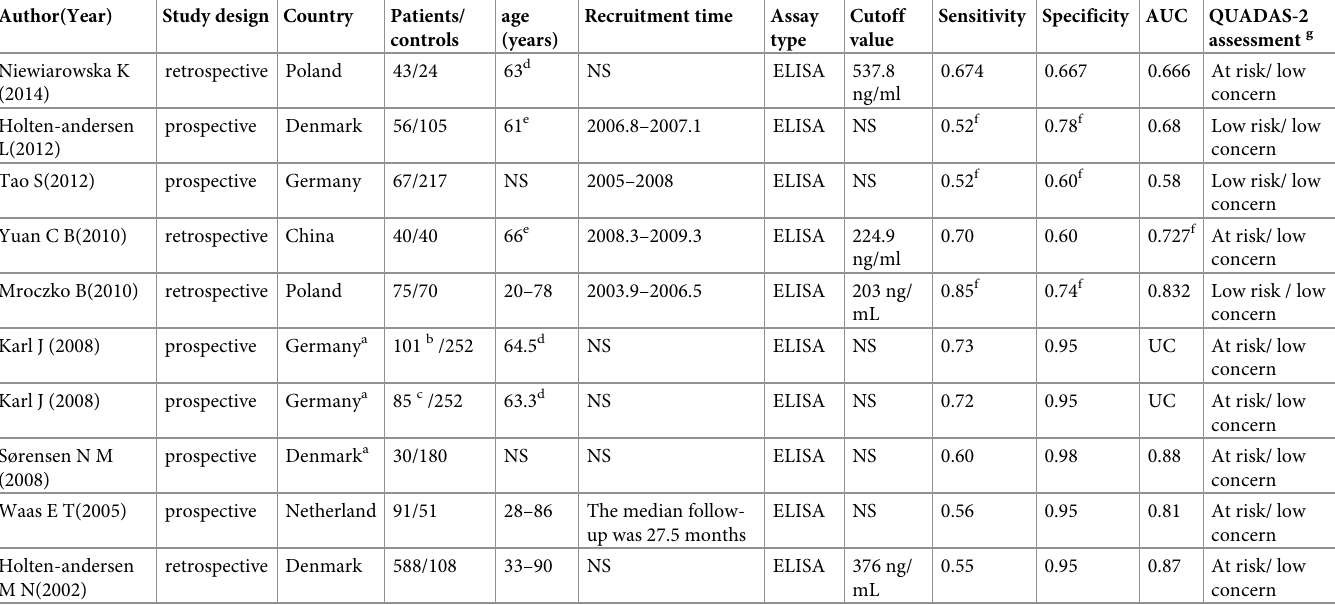
Table 1. Main characteristics of studies included in the